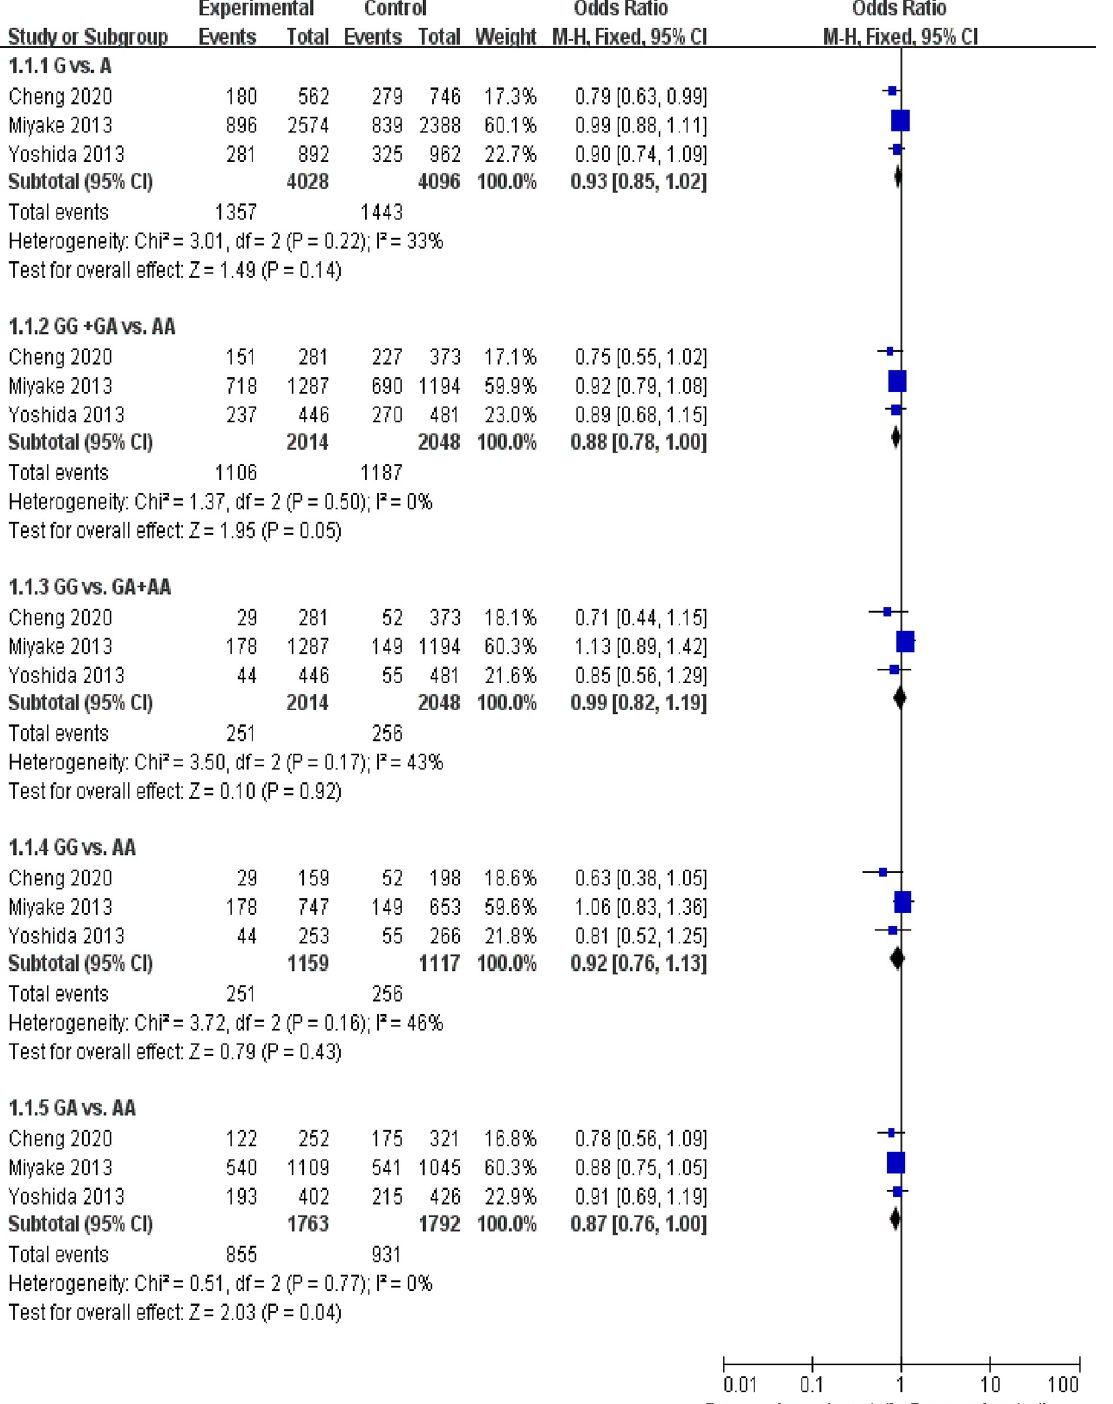
PLOS ONE | https://doi.org/10.1371/journal.pone.0271809 July 21,